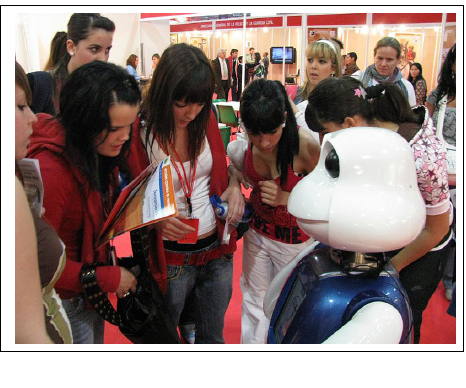
Figure 3. Interaction with children aged over